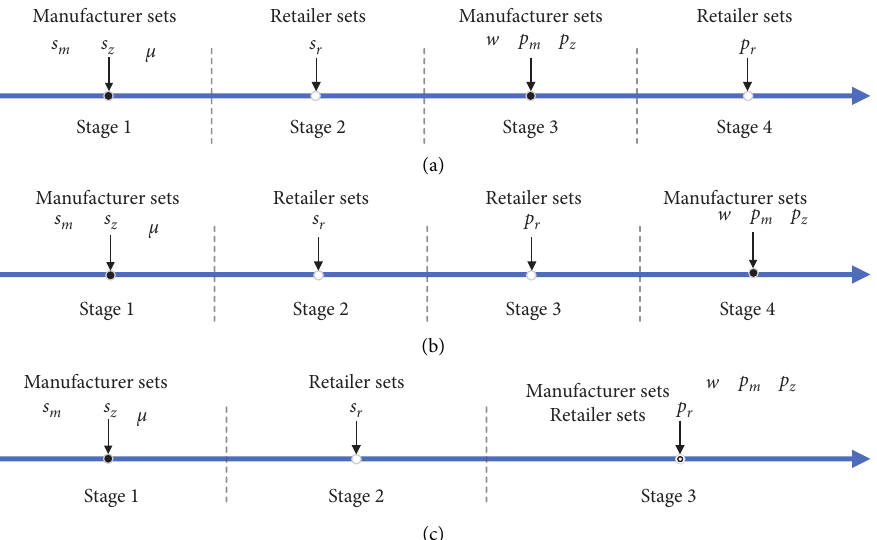
Figure 2: (a) Decision-making sequence in the MS model. (b) Decision-making sequence in the RS model. (c) Decision-making sequence in the Nash